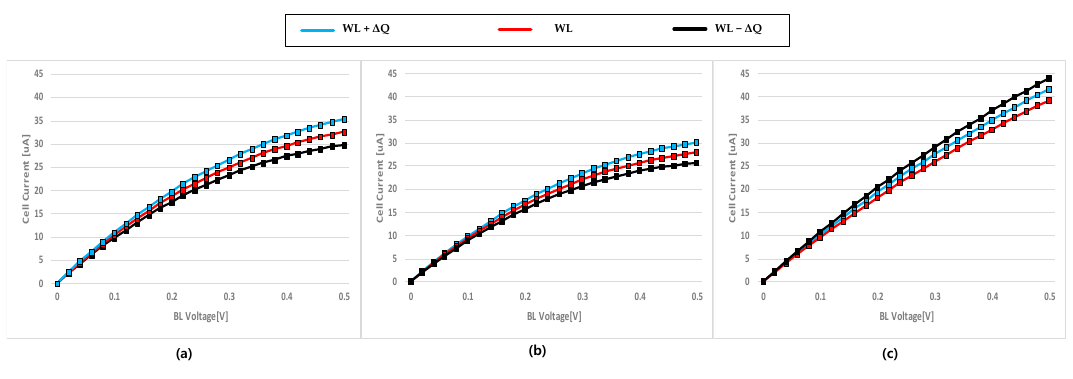
Figure 5. Drain current as a function of BL voltage for ( a ) CTT, ( b ) 2C-1T, and ( c ) 3C-1T cells. Table 4. Polynomial coefficients of the drain current in CTT, 2C-1T, and 3C-1T FET cells. Cell Type